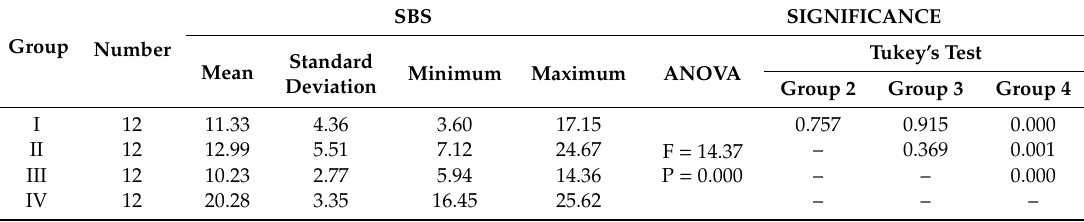
Table 2. Descriptive statistics and shear bond strength (SBS) comparison of four groups.